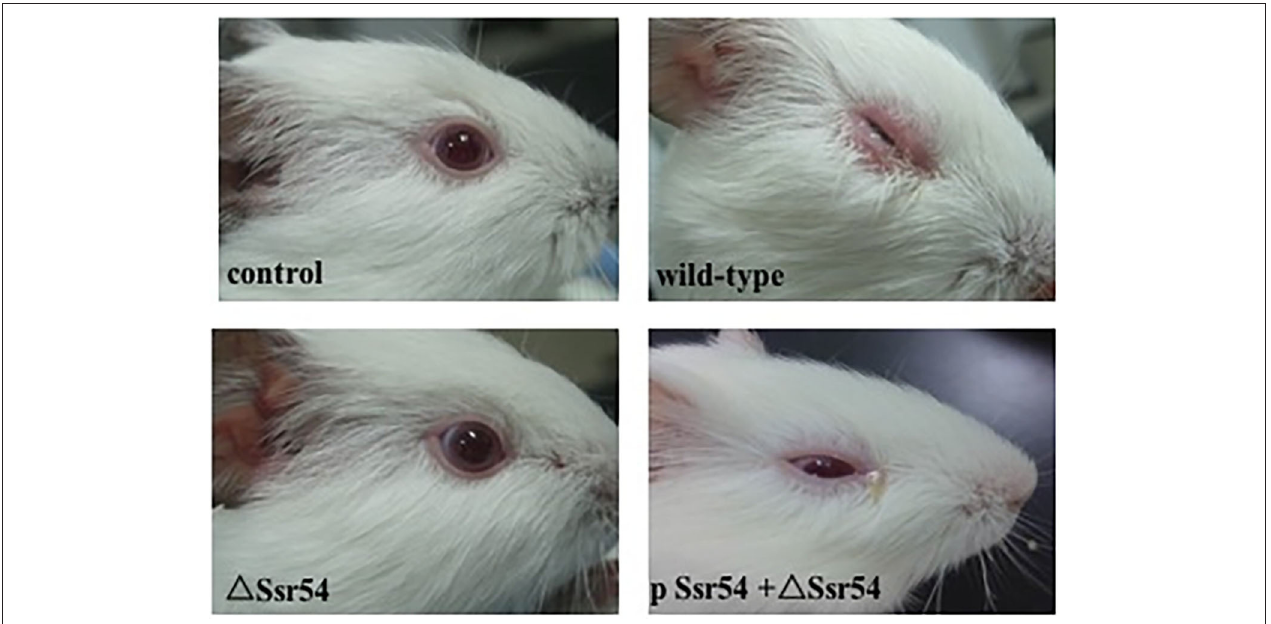
FIGURE 5 | Phenotypes of wild-type S. flexneri and sRNA mutant 1 Ssr54 in guinea pigs. More inflammatory cells were present in the corneas of guinea pigs inoculated with the wild-type and complement strains than those inoculated with the mutant 1 Ssr54 strain, whereas the NaCl (control) group showed no inflammatory cells.